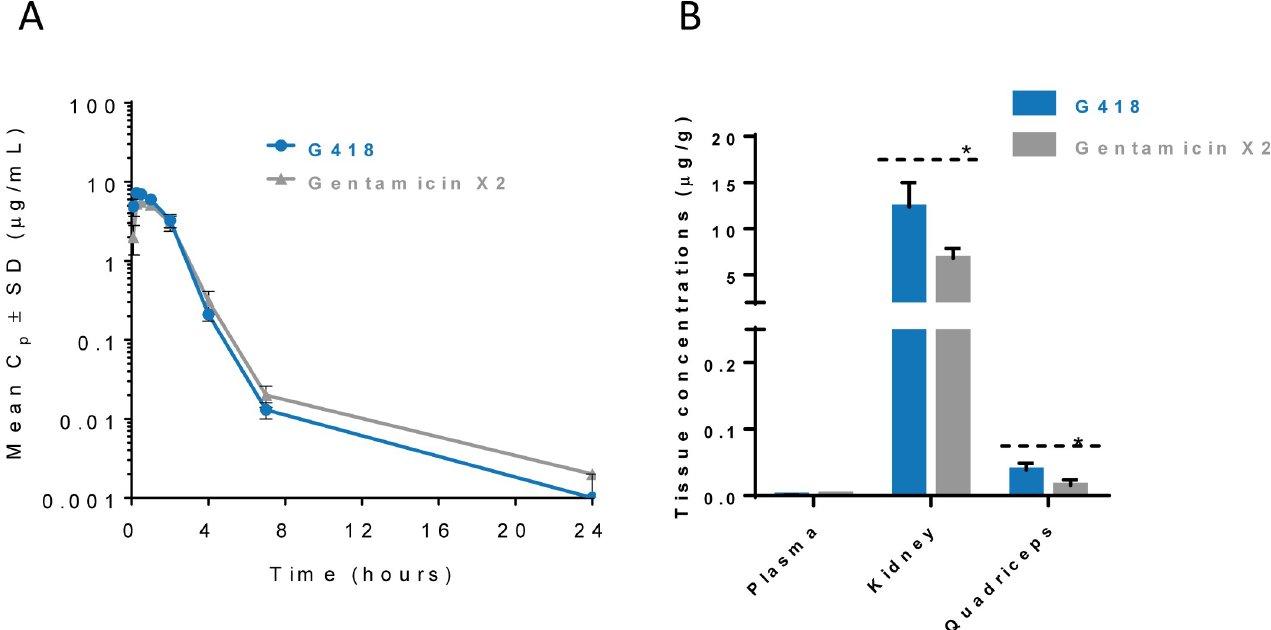
Fig 3. G418 and gentamicin X2 have similar pharmacokinetics in the rat. (A) G418 and gentamicin X2 were administered by subcutaneous injection to rats at a dose of 10 mg/kg. Plasma was collected at the indicated time points and drug levels were determined. Symbols represent the mean of three rats ± standard deviation (SD) per group. (B) G418 and gentamicin X2 accumulate in kidney tissues. The concentration of aminoglycoside in the tissue ( μ g compound per gram wet weight of tissue) at 24 hours post-dose is the mean ± SD of three rats. Levels of aminoglycosides were at or below the lower limit of quantification. � p < 0.05 (Student’s t-test).